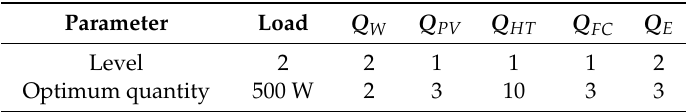
Table 6. Optimum Parameters of the ETM.